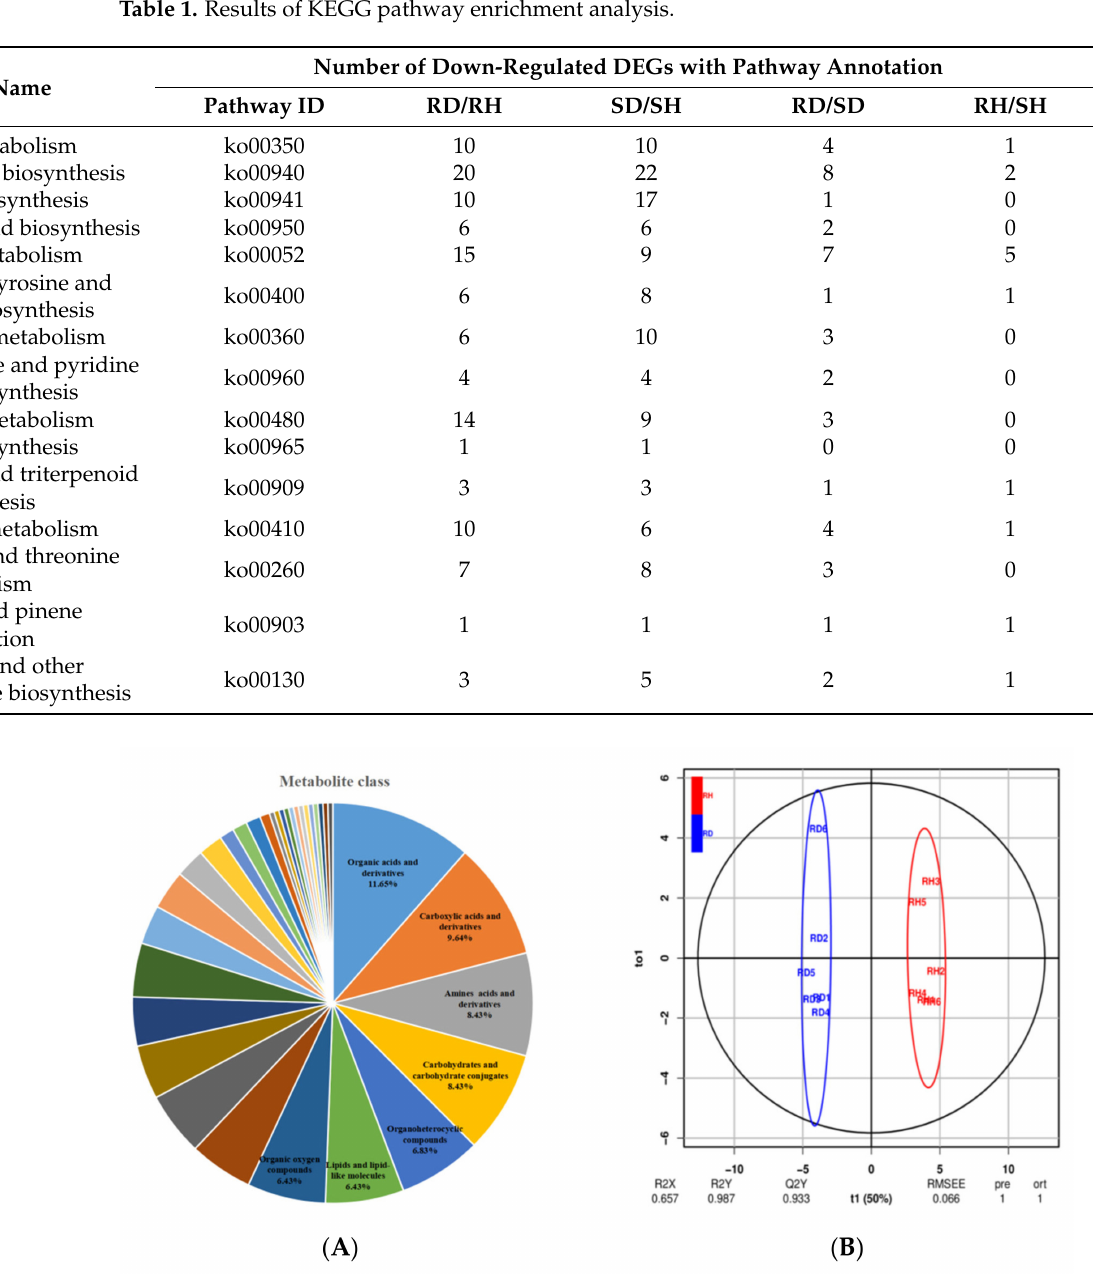
Table 1. Results of KEGG pathway enrichment analysis.